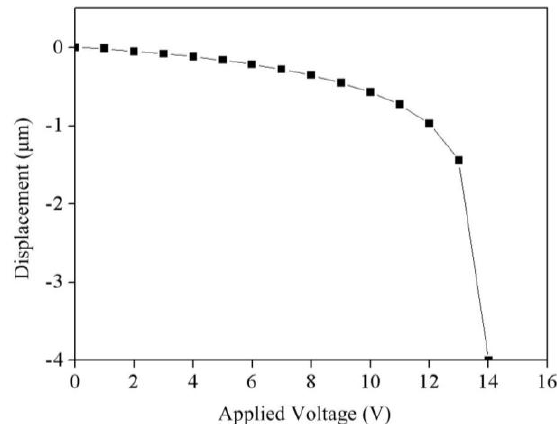
Figure 3. Relation between actuation voltage and membrane displacement.